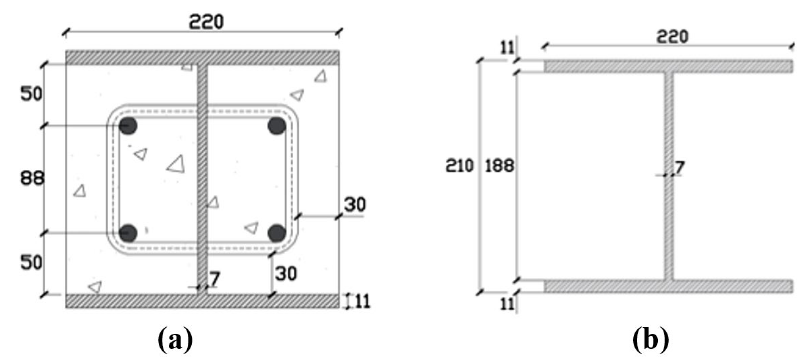
Figure 1. Geometric characteristics of the studied columns, considering as cases of interest: (a) steel and concrete composite, and (b) Purely